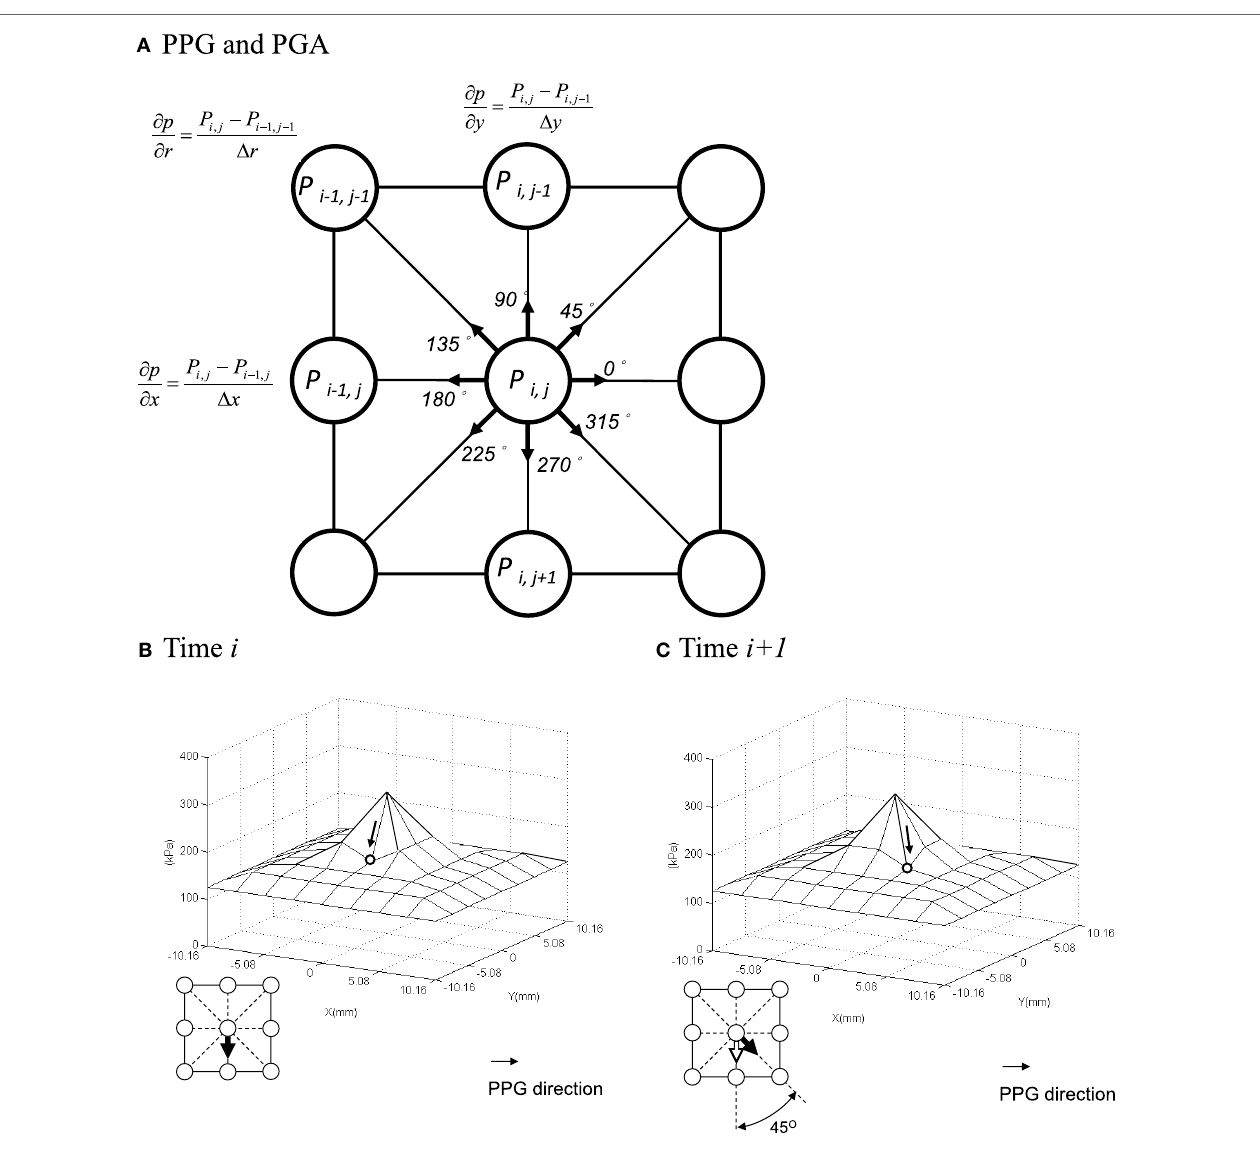
FigUre 1 | illustrations of the peak pressure gradient (PPg) and pressure gradient angle (Pga) . (a) Calculation of the PPG. (B,c) Quantify the time- varying directional variations of pressure gradients (i.e., PGA). The PGA is 45° from (B) time i to (c) time i + 1. Although the PPP and PPG values are the same, the directions of PGA are different. The arrow represents the direction of peak pressure